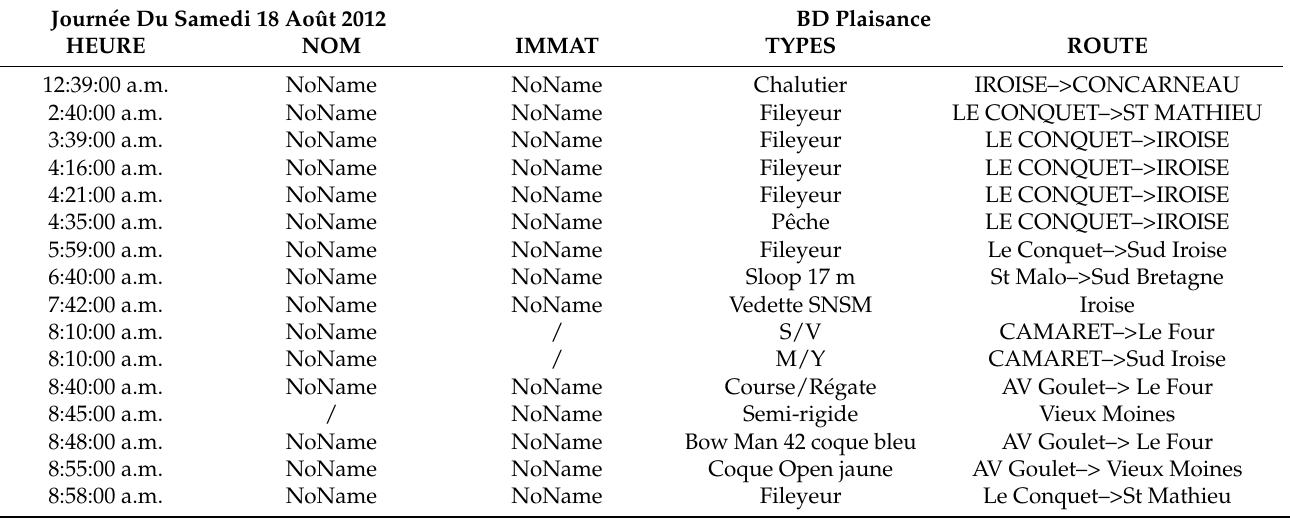
Table 1. Extract from the raw data (anonymized) for the Saint-Mathieu s é maphore. The English version of this table is available in the supplementary